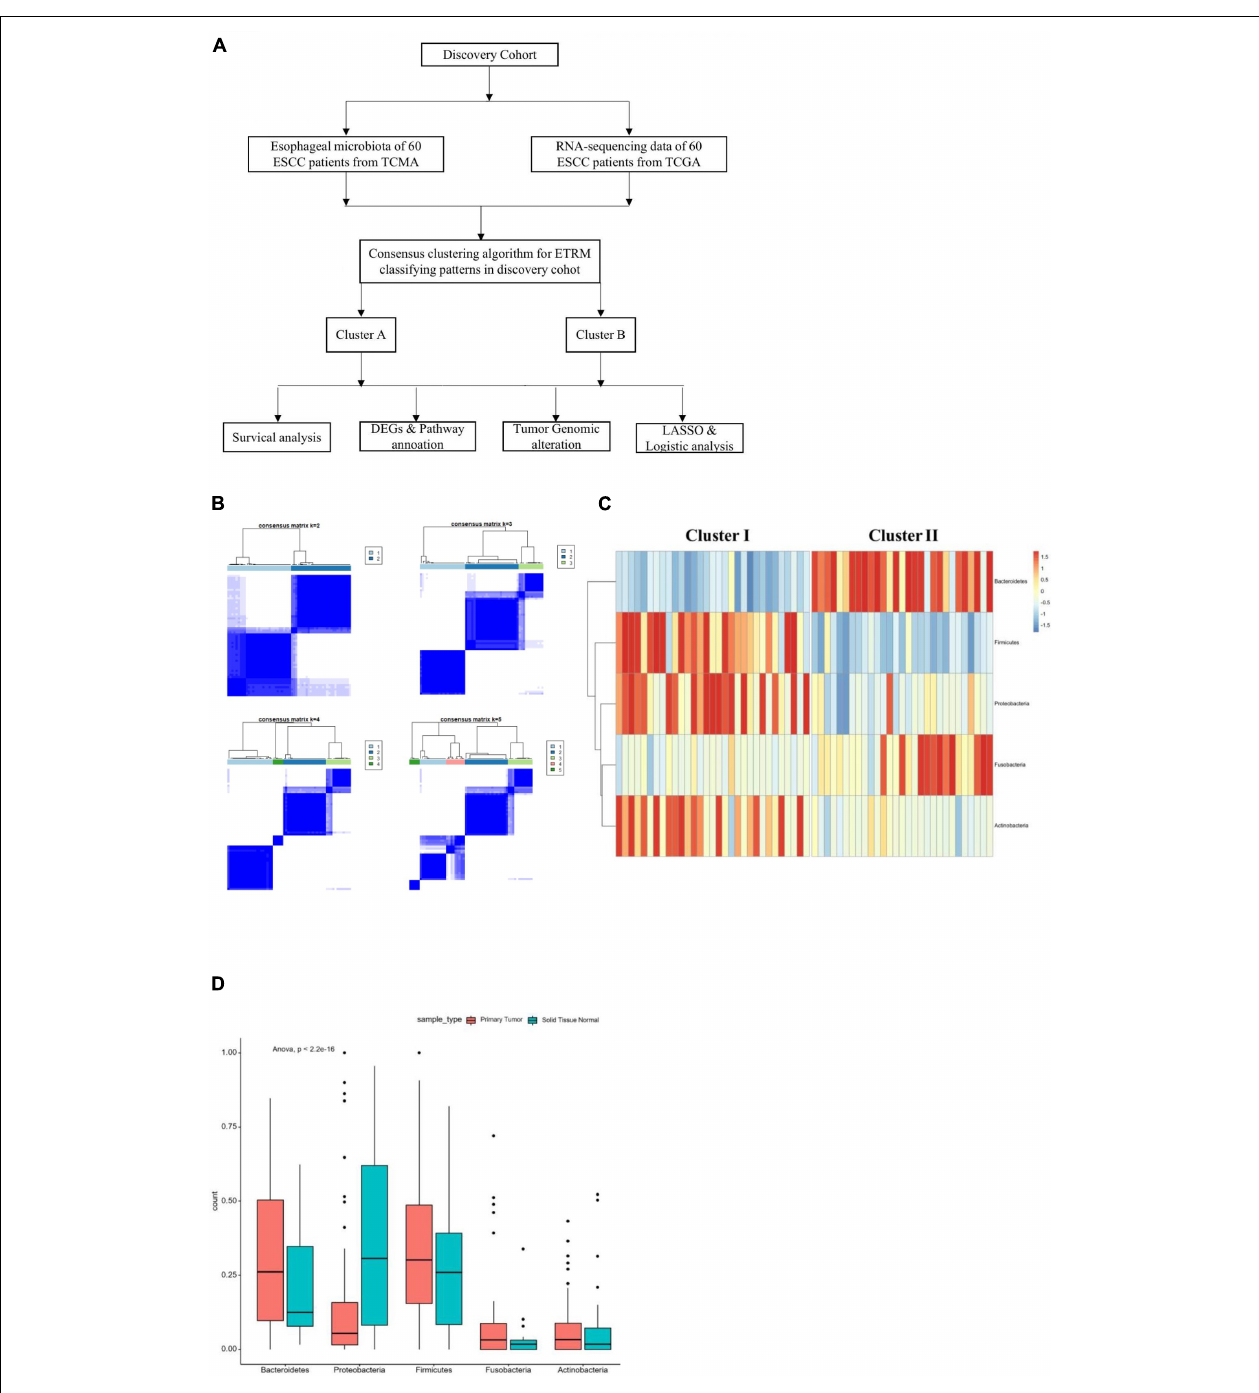
FIGURE 1 | (A) Construction of the study. (B) Consensus matrixes of all sample cohorts for each k (k from 2 to 5) demonstrate the stability of clustering through 2000 HYPERLINK “javascript” hierarchical clustering. (C) All-randomized clustering of esophageal-tissue resident microbiota for 60 samples from both TCGA and TCMA. (D) Proportion of the most significant esophageal tissue-resident microbiota in the primary tumor and solid normal tissue according to the best clustering ( Table 1 ). Basic characteristics of the ESCC patients in the two infiltration groups from the TCGA database.